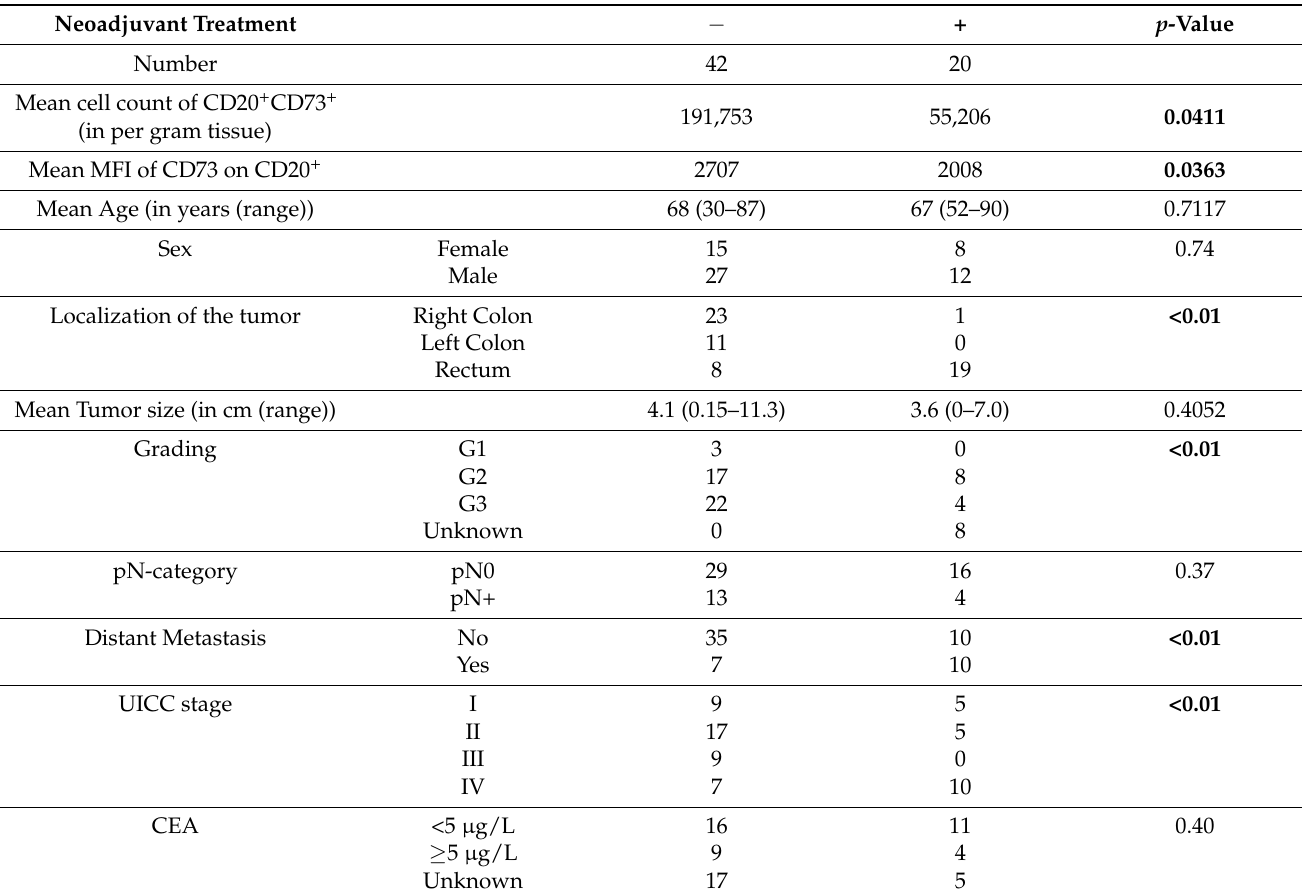
Table 2. Clinicopathological characteristics of the patients grouped according to the status of neoad- juvant